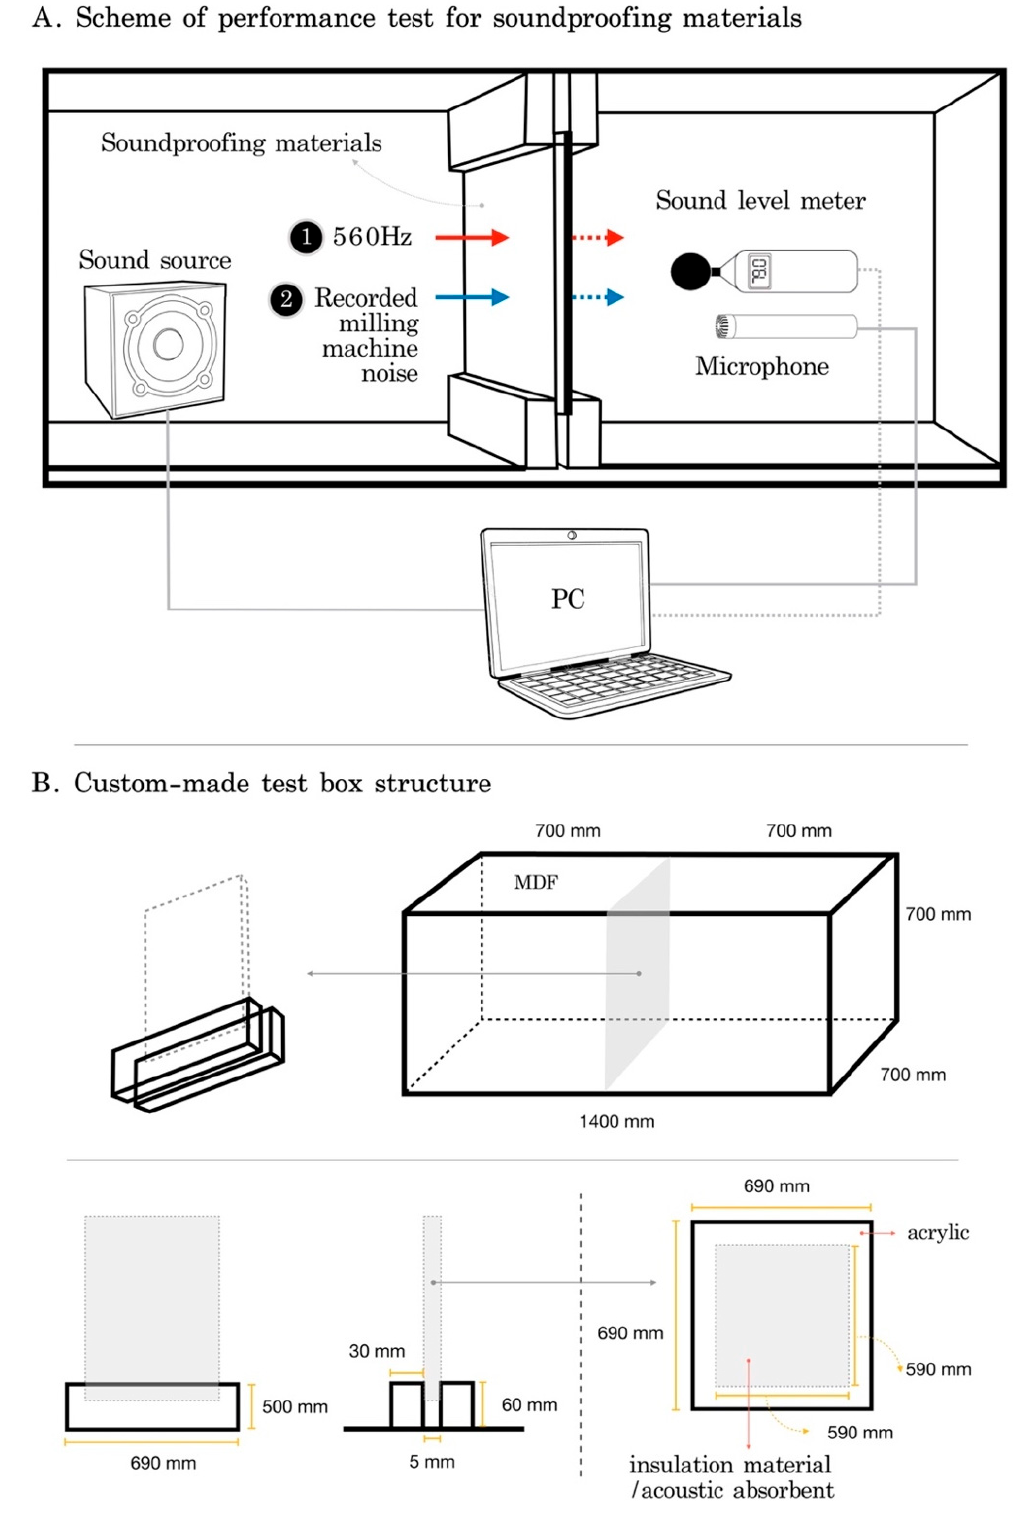
Figure 8. Method for evaluating the performance of soundproofing materials. ( A ) scheme of the performance test for soundproofing; ( B ) a custom-made test box structure.